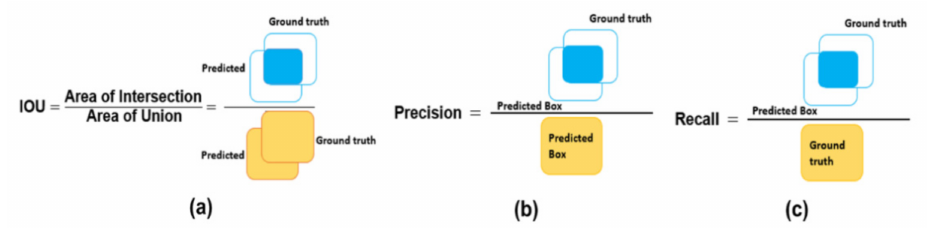
Figure 5. Geometrical representations ( a ) IOU, ( b ) precision, and ( c ) recall.